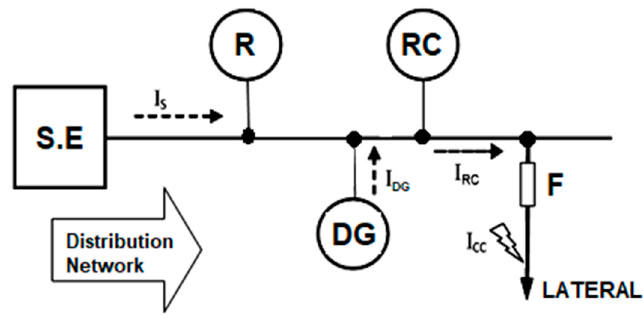
Figure 6. Short circuit in branch line.